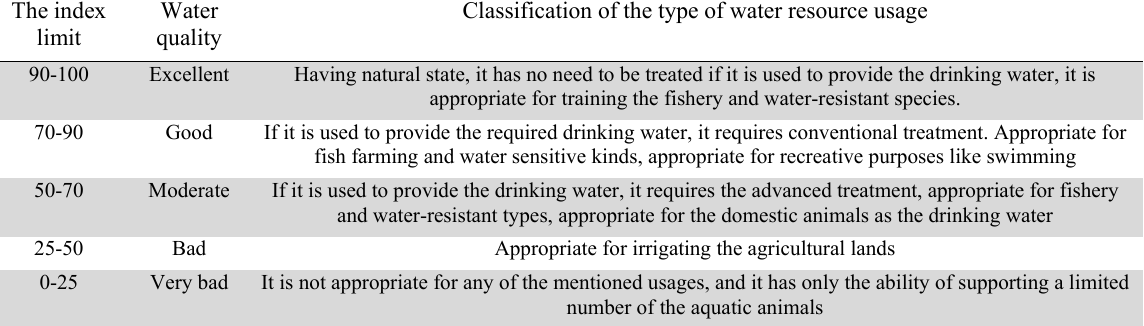
The guide of the water quality index